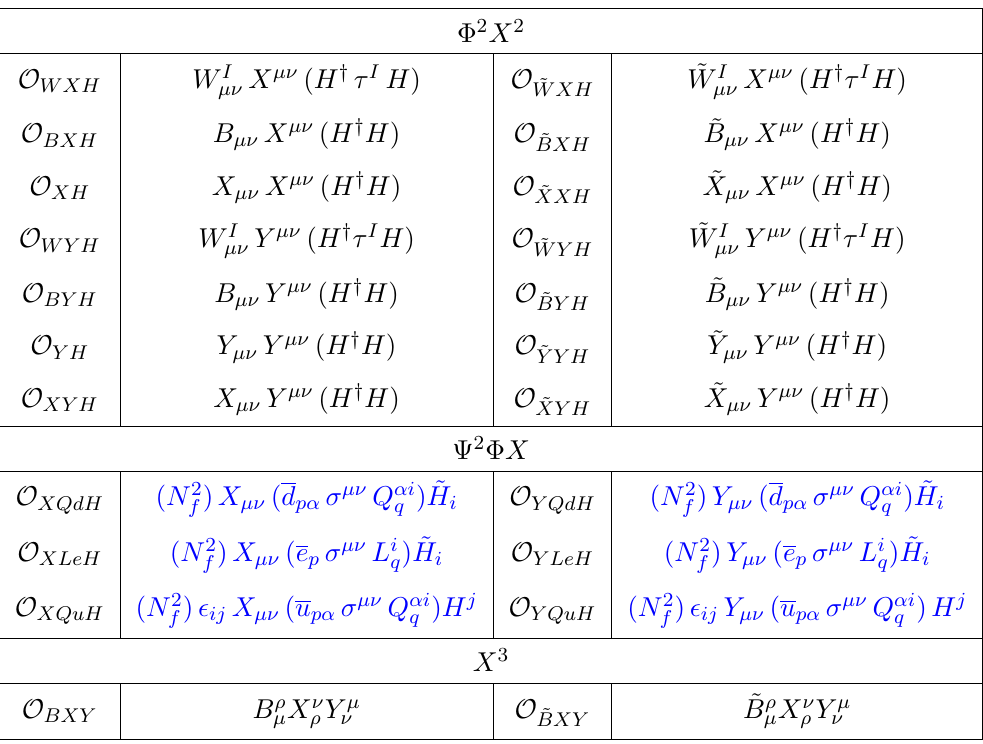
Table 25 . SM extended by two abelian gauge groups: additional operators of dimension 6. Here i, j and α are the SU(2) and SU(3) indices respectively. τ I is the SU(2) generator, I = 1 , 2 , 3 . p, q = 1 , 2 , · · · , N f are the flavour